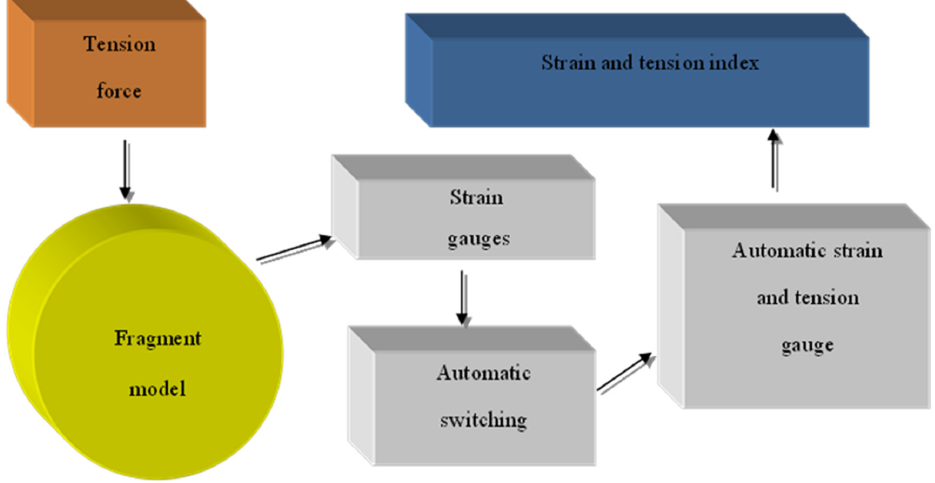
Figure 1. Flowchart of experimental